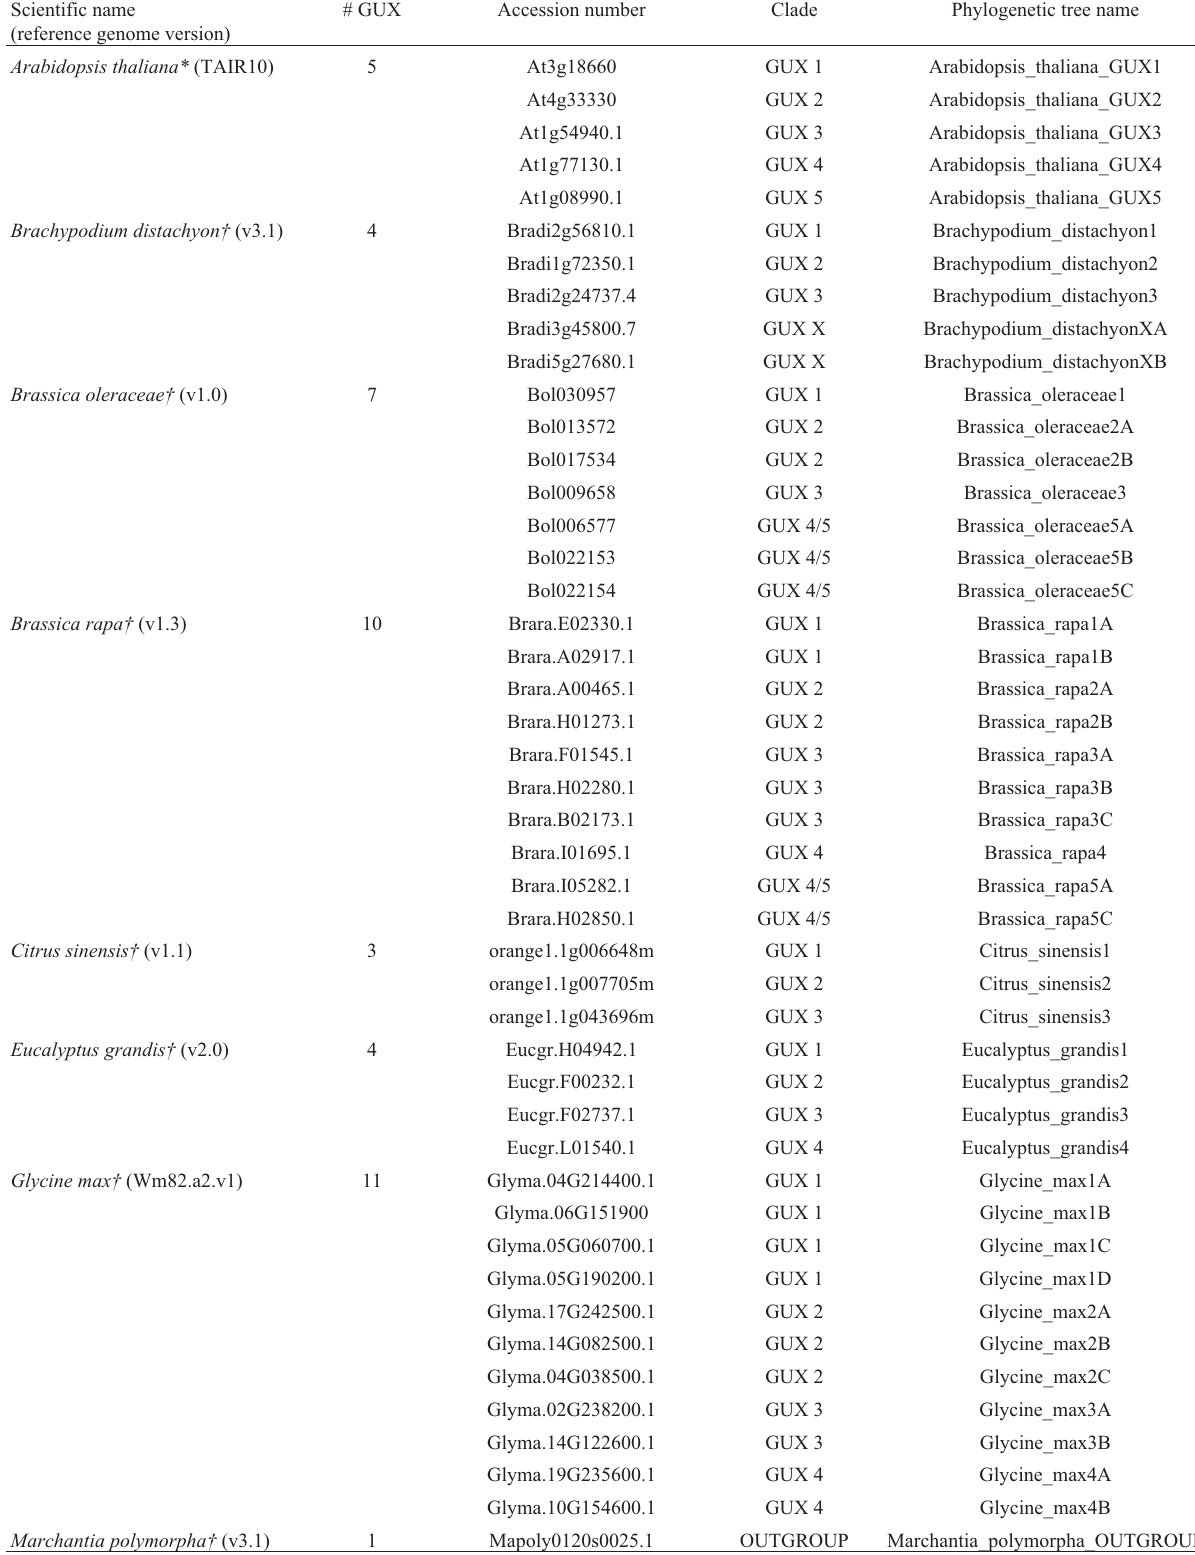
Table 1 - Number of GUX proteins found by HMMER analysis in each species, scientific name, accession number, clade that each protein belongs and the name that appears on the phylogenetic